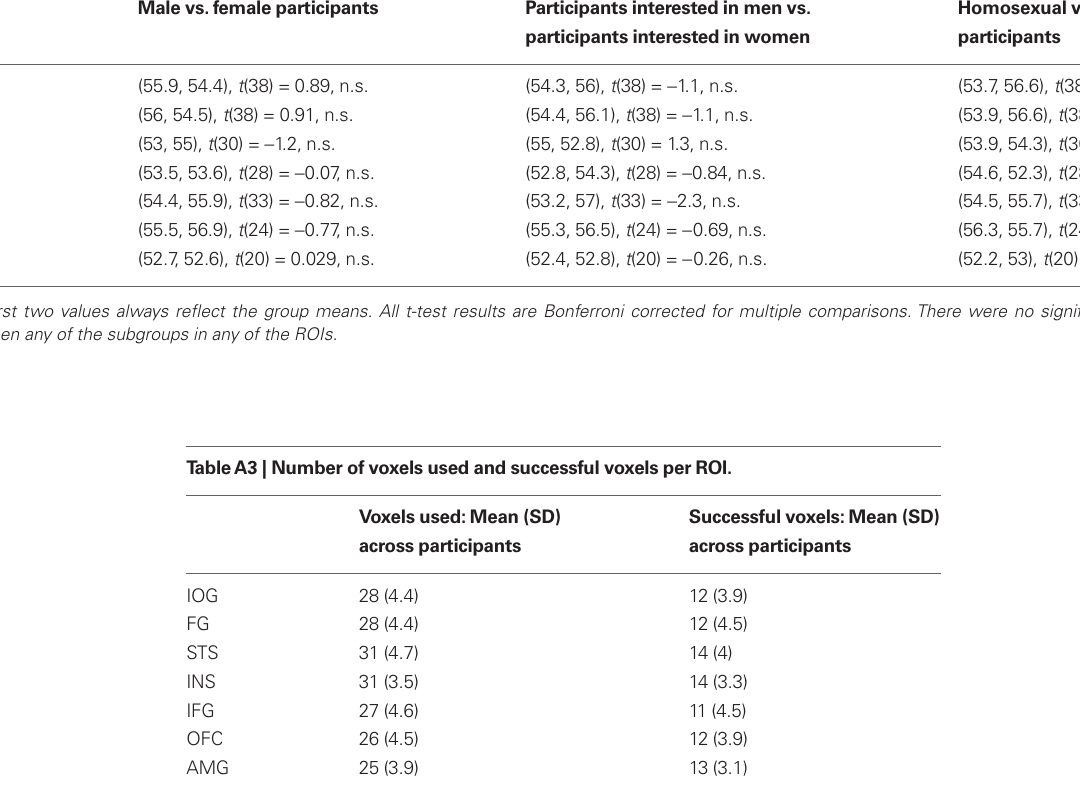
Table A2 | Complete table of statistical values for t -tests between different subgroups of the participant population. Male vs. female participants Participants interested in men